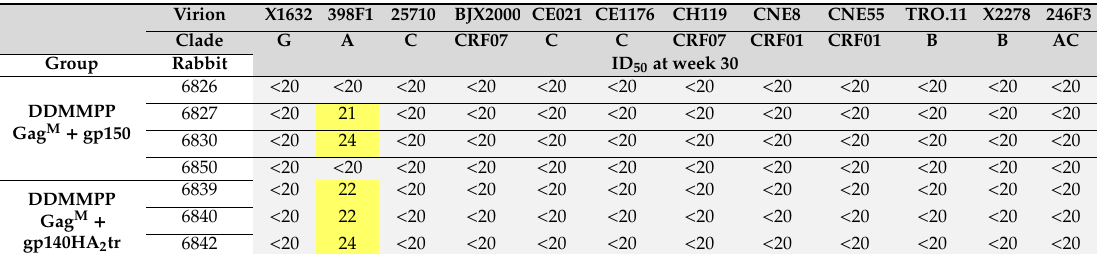
Table 3. Neutralizing antibody titers elicited in rabbits against a global panel of